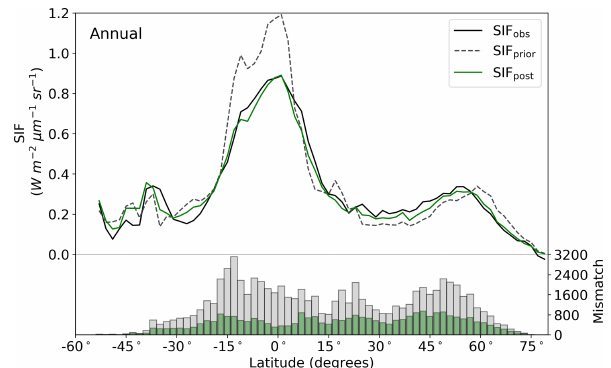
Figure 4. Latitudinal averaged SIF and mismatch with observa- tions. OCO-2 observations (black line), SIF prior (gray dashed line, gray bars) and SIF post (green line, green bars) for the annual aver- age. Data are only shown for spatiotemporal points where OCO-2 observations are present.